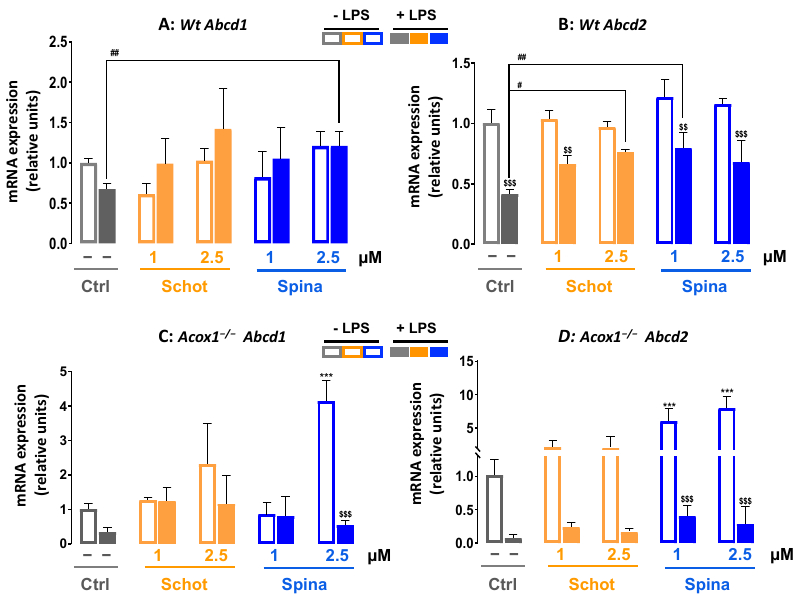
Figure 8. Effect of Schot or Spina treatment on the gene expression of Abcd1 ( A , C ) and Abcd2 ( B , D ) in Wt ( A , B ) and Acox1 − / − ( C , D ) BV-2 microglial cells. Cells were incubated for 24h with Schot or Spina (1 or 2.5 µM) in the absence or presence of LPS (1 µg/mL). Total RNA was isolated from BV-2 cells, and then the expression level of genes of interest was quantified by real-time RT-qPCR. All values are presented as means ± SD of two independent experiments performed in triplicate, with the statistical significance of the increased mean signal indicated as *** p ≤ 0.001 compared to control; ## p ≤ 0.01 and # p ≤ 0.05 compared to LPS; and $$$ p ≤ 0.001 and $$ p ≤ 0.01 compared to the different treatments with or without LPS administration. Statistical significance was determined using two-way ANOVA followed by Tukey’s test for multiple comparisons.